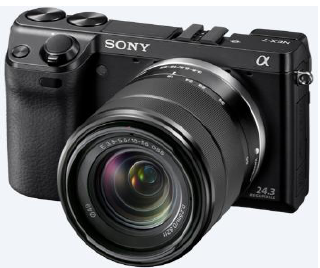
Figure 5. View of Digital Sony NEX-7, camera used in experiments During fieldwork were also measured control and checkpoints by means of GPS technology. Distribution of the points you can see in the Fig.6 on the background of photos of classic camera Ultra Cam Eagle. Red circles denote control points and blue points denote "check points". Black points represent "tie- points".